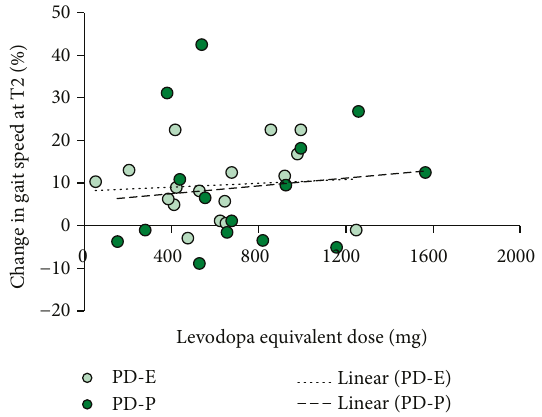
Figure 8: The regression lines are drawn through the data points representing the percent changes in gait speed at T2 against medication. There was no e ff ect of total medication (expressed as levodopa equivalent dose) on changes in gait speed, in either treatment